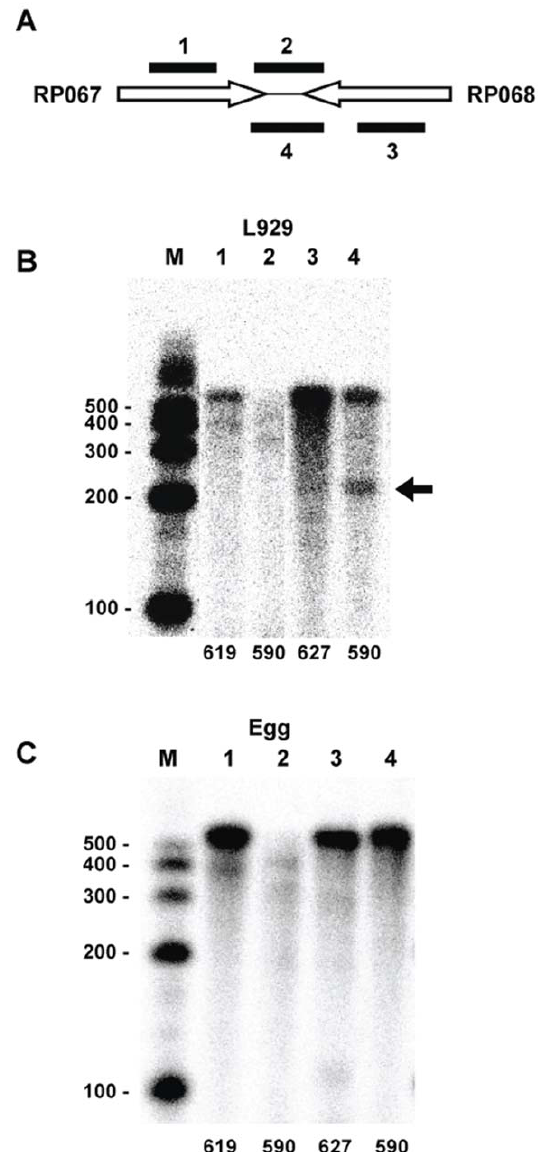
Figure 4. RPA analysis characterizing transcripts of the RP067- RP068 gene pair region. (A) Schematic indicating the relative positions of the RPA probes targeted to the convergent gene pair. The probes include two internal probes to confirm gene transcription and two intervening probes of opposite orientation to detect intergenic mRNA. Probes 1 and 2 hybridize to RP067 transcripts while probes 3 and 4 hybridize to RP068 transcripts. (B) RPA analysis of RNA isolated from rickettsiae harvested from L929 cells. Lanes were digitally moved horizontally using Microsoft Office PowerPoint to maintain consistent lane organization. (C) RPA analysis of RNA isolated from rickettsiae harvested from egg yolk sacs. Lane numbers correspond to probe numbers in the schematic. Numbers at the bottom of each lane in B and C correspond to the size of the probe in bases. M, sized markers with sizes (in bases) indicated. The arrow indicates a band resulting from specific termination of RP068 transcripts.